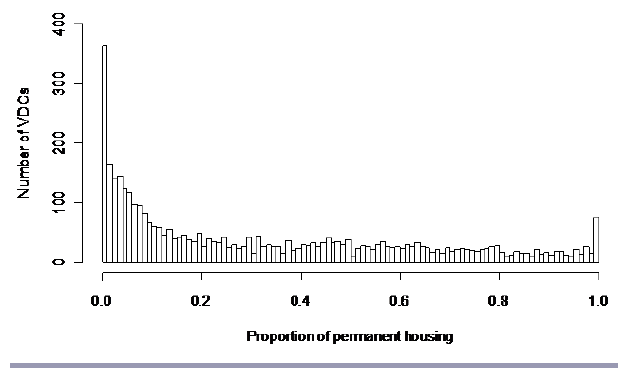
Fig. 3 . Frequency distribution of proportion of permanent housing in Village Development Committees (VDC) and municipalities in Nepal.